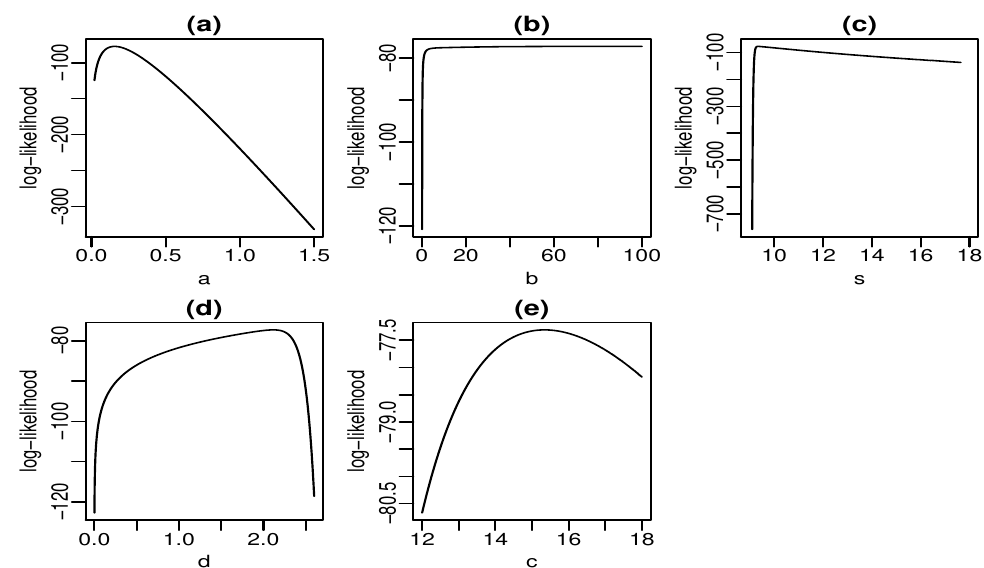
Figure 7. Profile log-likelihood functions for turbocharger data ( a – e ).